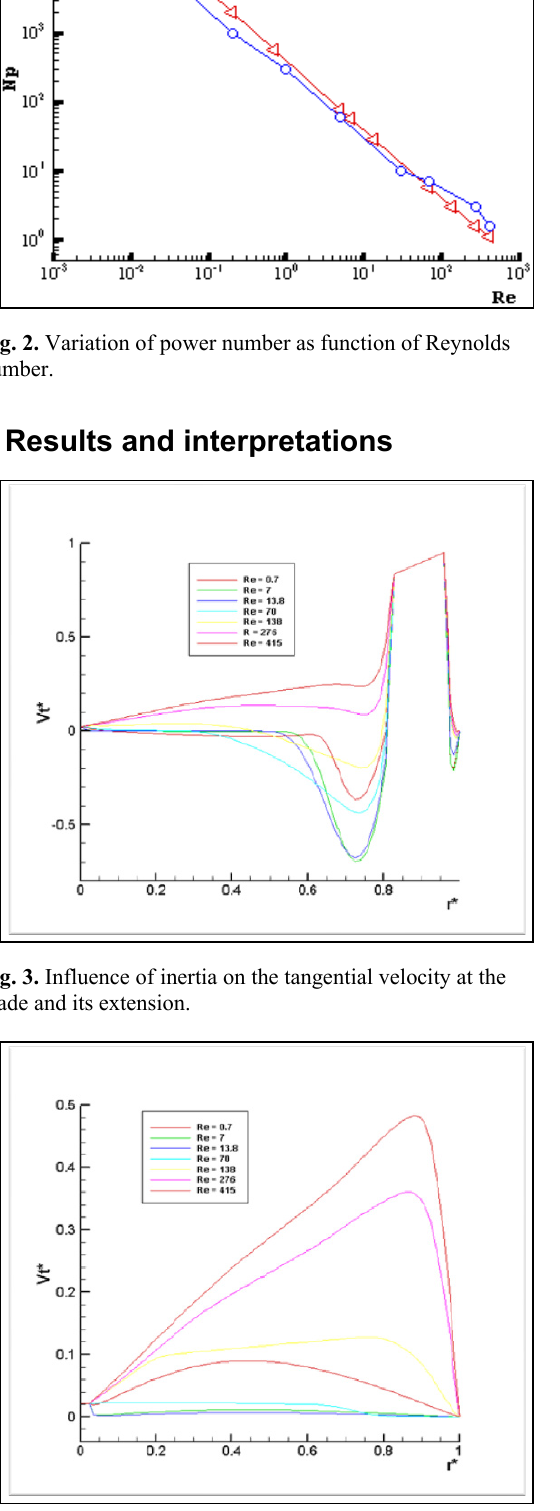
Fig. 4. Influence of inertia on the radial velocity at the blade and its extension.